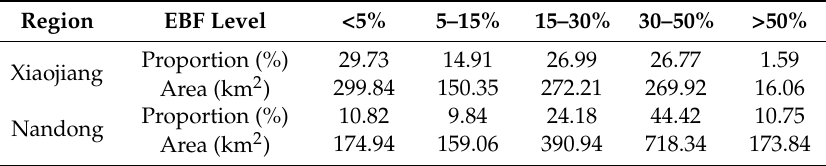
Table 3. Statistical results of EBF in the Xiaojiang and Nandong